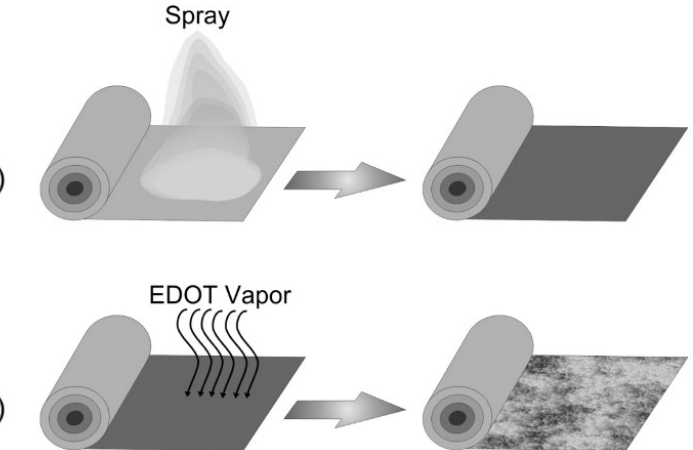
Figure 12. Schematic representation of PEDOT coating onto an Al current collector. ( 1 ) Aerosol deposition of Fe (III) p-toluenesulfonate hexahydrate. ( 2 ) Chemical vapor polymerization of PEDOT [113]. Reprint with permission from [113]; Copyright 2019, Elsevier.